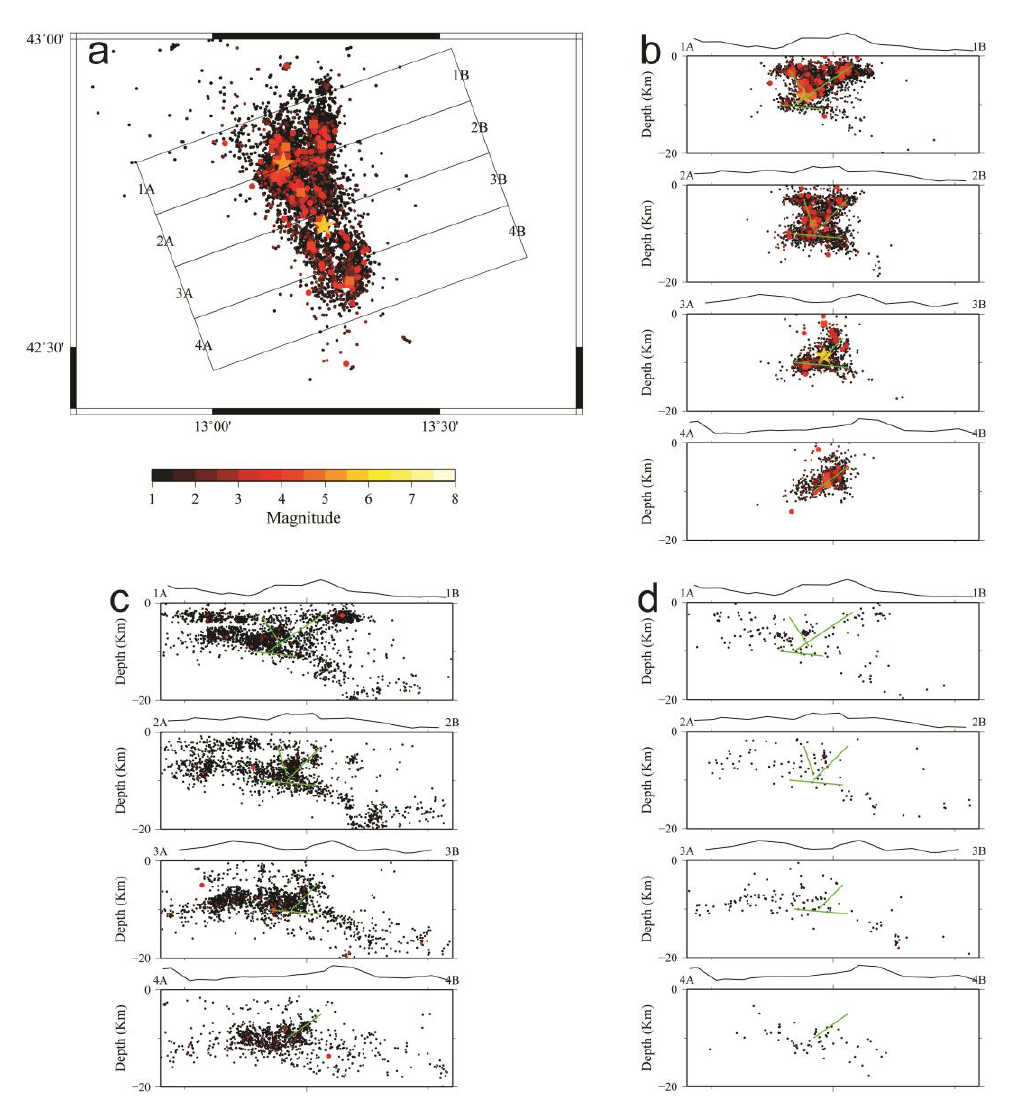
Figure 3. Sketch of seismicity in depth: a) map of Amatrice sequence; b) sections of Amatrice sequence; c) sections of four years seismicity from 2012 to 2016; d) sections of seismicity of the last 4 months before the Amatrice sequence. Thin green lines: main trends of the seismicity